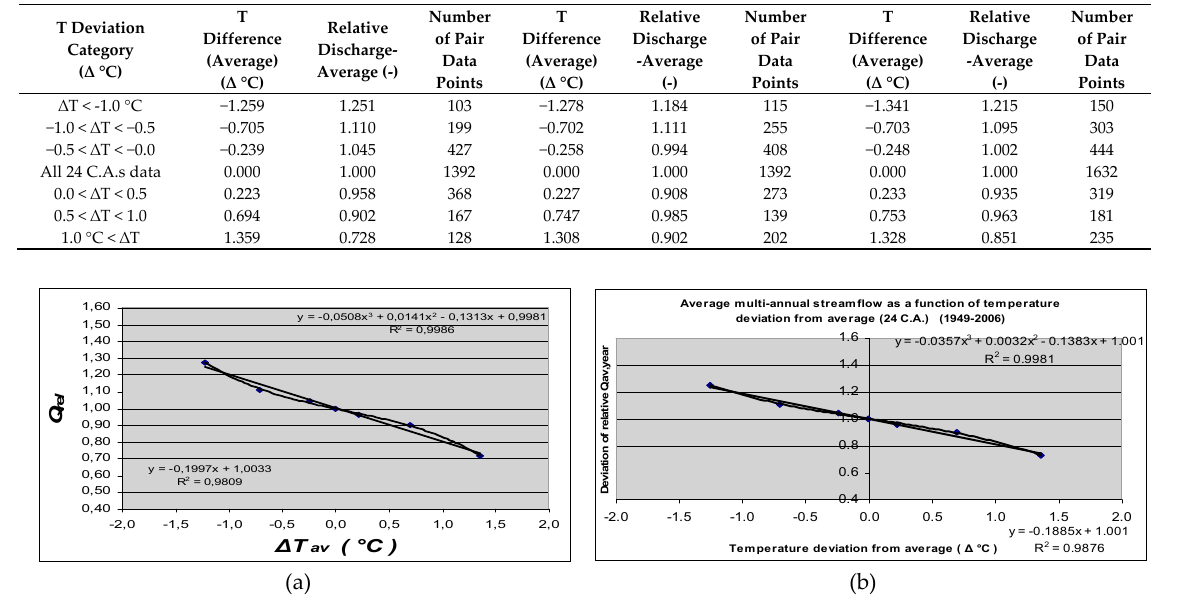
Table 4. Average relative values for T and Q for all T deviation categories and all three periods. Period